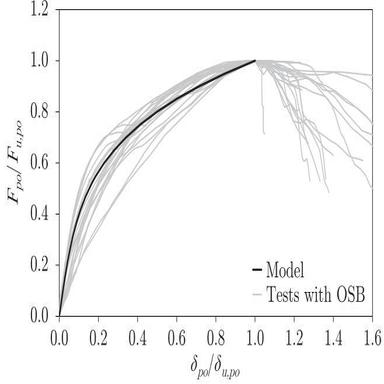
Comparison between the proposed load-slip model and normalised test curves for specimens with OSB.